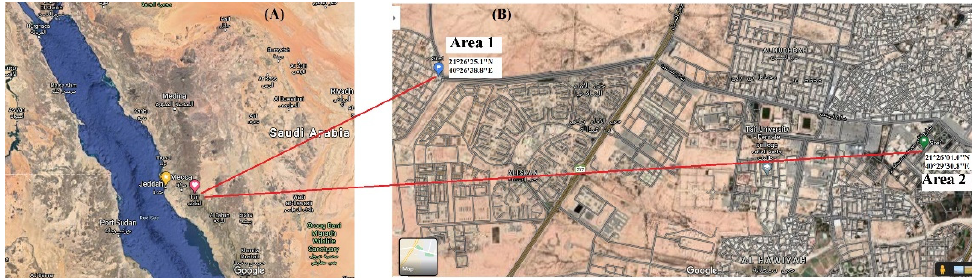
Figure 1. Map of Kingdom of Saudi Arabia showing high-altitude Taif Governorate ( A ) and sample collecting areas (21°26’25.1” N 40°26’38.8” E and 21°26’01.0” N 40°29’30.8” E) in Taif ( B ) (Google Map 2020).